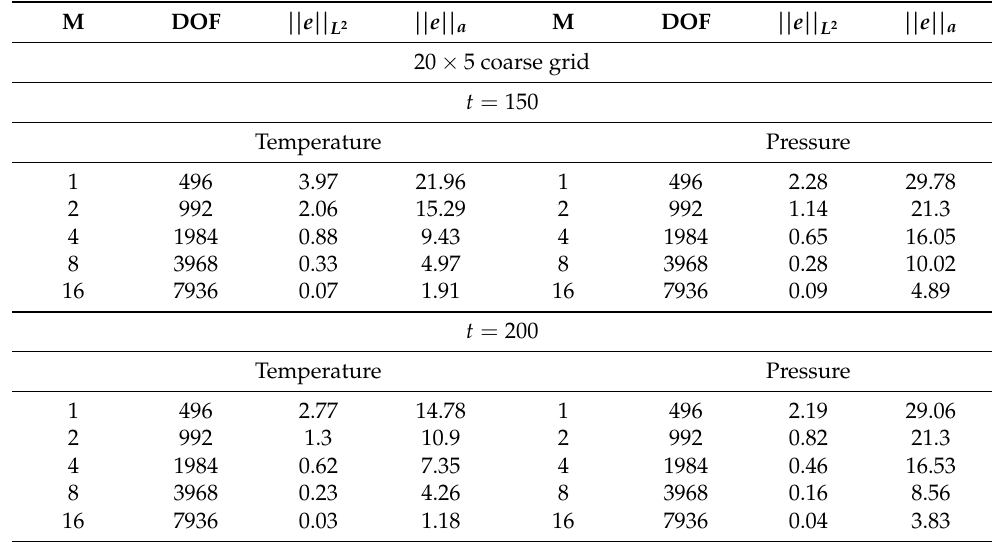
Table 2. Relative L 2 and energy errors (%) for different number of multiscale basis functions. ( DOF f = 29,041).